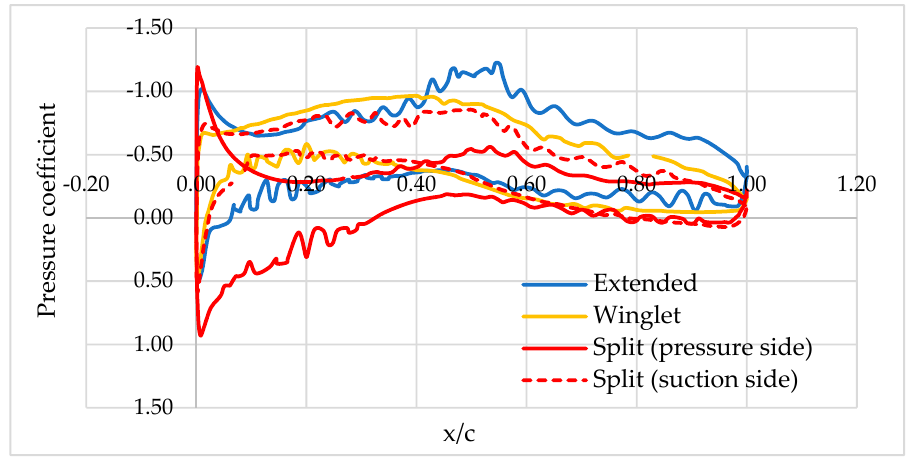
Figure 9. Pressure contour at the rotor blade tip at V = 11 m/s.